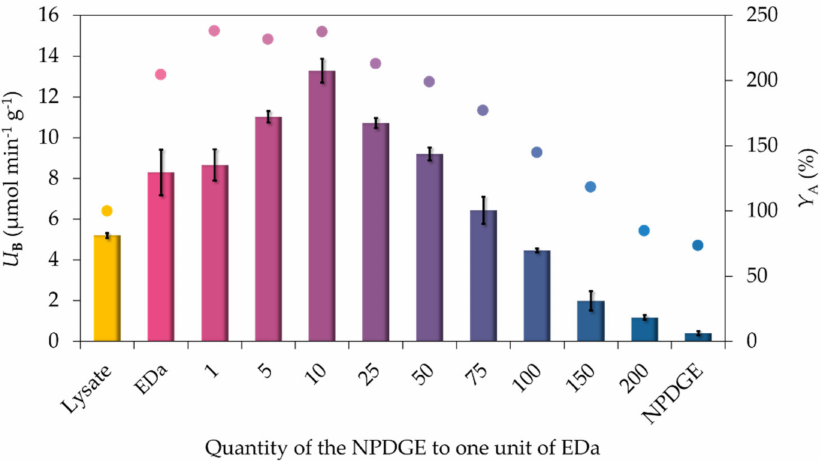
Figure 3. E ff ect of the bisepoxide to ethylenediaminetetraacetic dianhydride ratio in surface functionalization on the activity of the immobilized Pc PAL biocatalyst. Lysate: crude protein